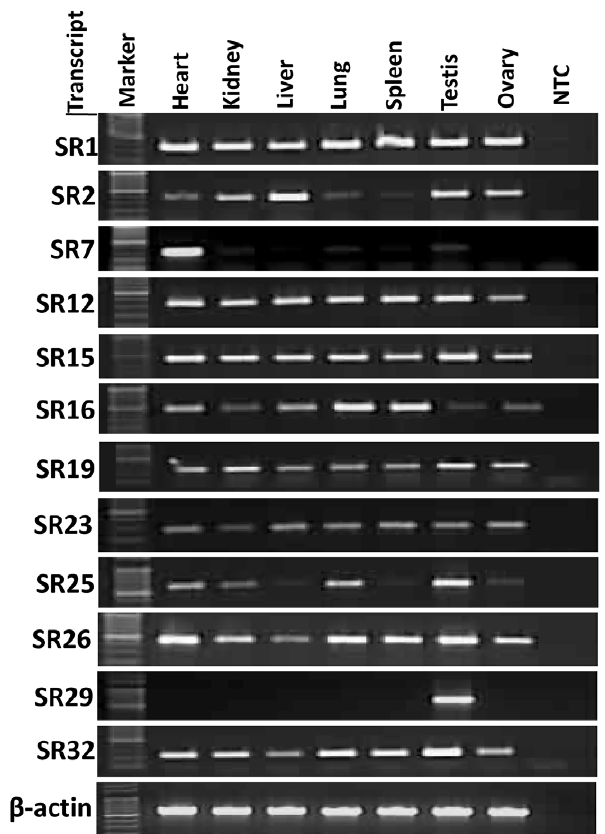
Figure 2. RT-PCR analysis of the (TGG) n tagged mRNA transcripts using internal primers and cDNA from different somatic tissues and the gonads. The quality and quantity of the cDNA samples were assessed using beta-actin specific primers and are shown at the bottom. The transcript IDs are indicated on the left and the tissues IDs at the top of the panel. NTC denotes non-template control.